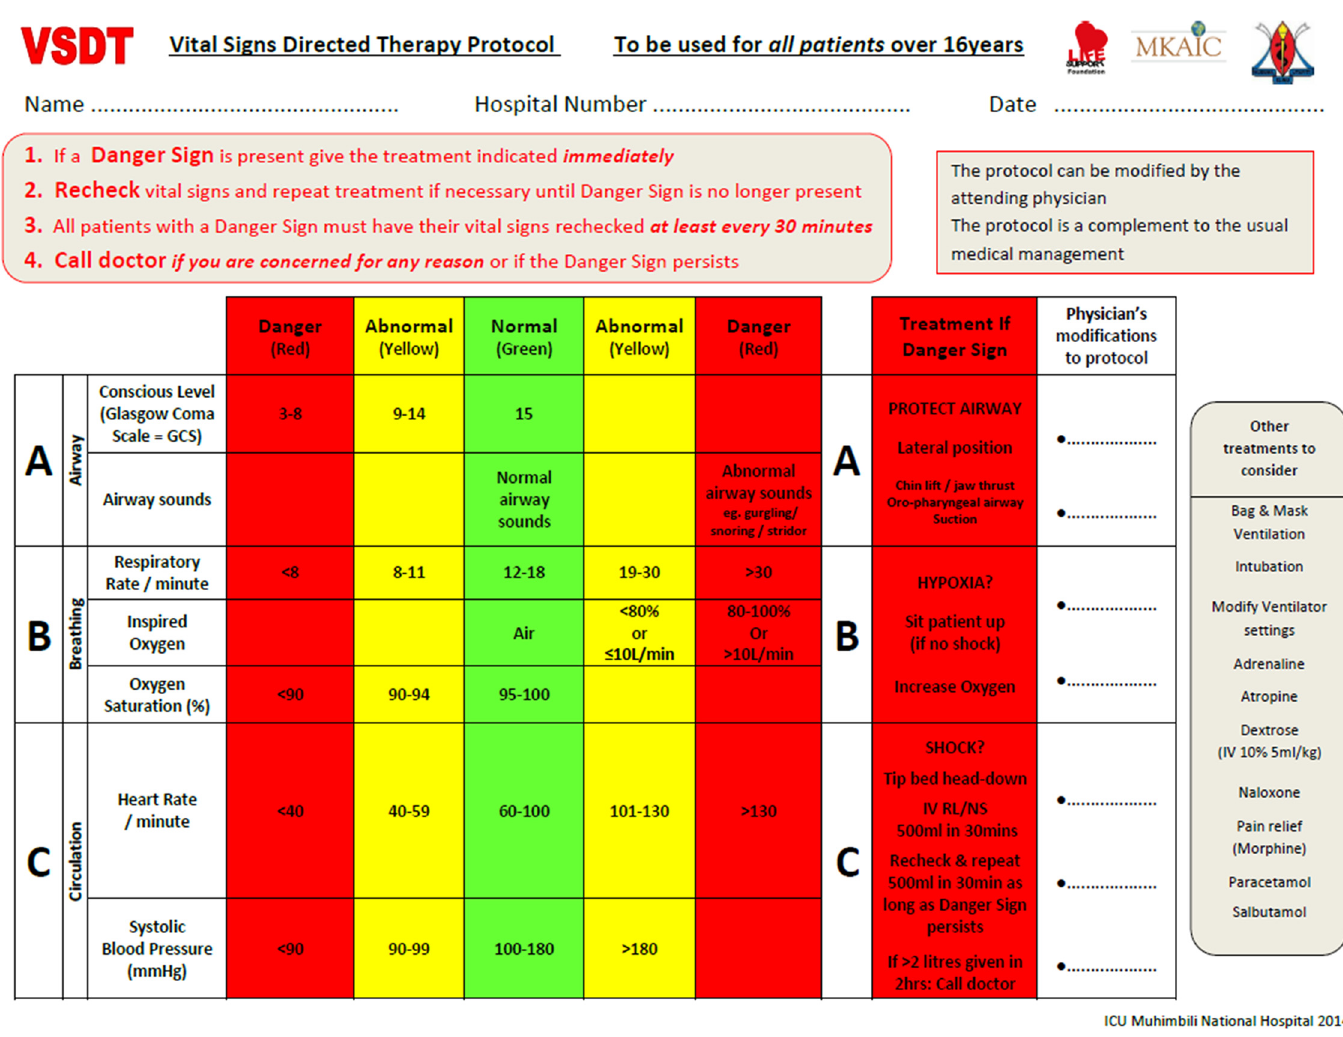
Fig 1. Vital Signs Directed Therapy